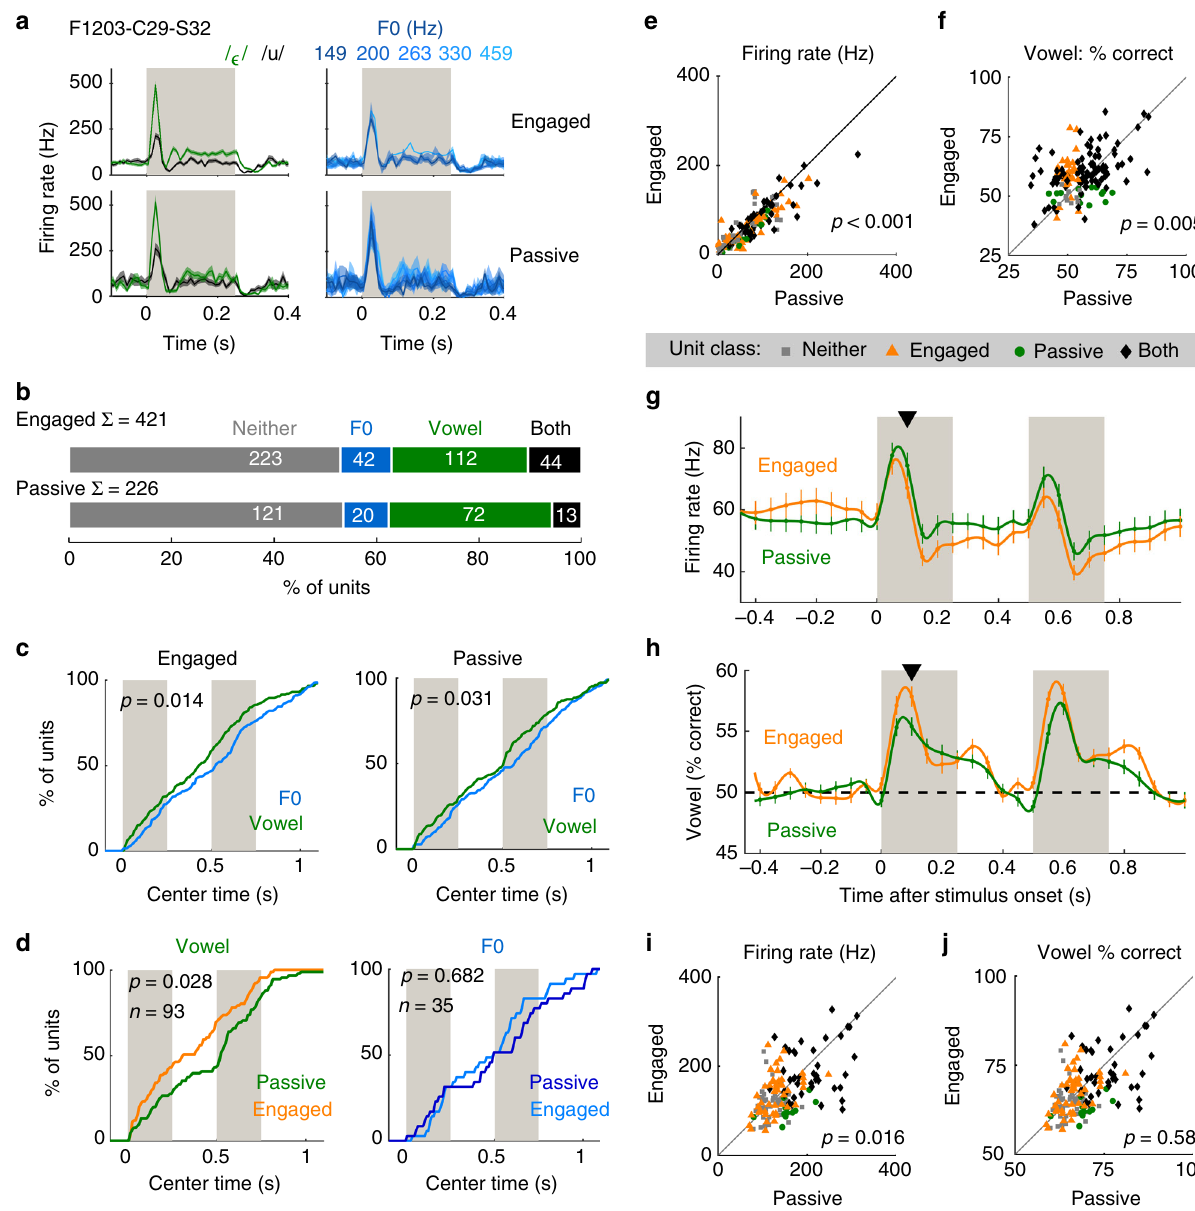
Fig. 3 Modulation of auditory processing by task engagement. a Example unit responses recorded during task engagement and passive listening to vowels (/u/: black; / ε /: green) varying in F0 (blue). Data are shown as mean ± s.e.m. fi ring rates across trials (sample sizes given in Supplementary Table 6). b Proportion of units informative about vowel identity and/or F0. Σ shows sample size; note that not all units recorded during passive listening were recorded during task engagement. c Cumulative density functions (CDF) showing the distribution of decoding time windows giving best performance when decoding vowel (green) and F0 (blue). Data are shown for all units that were informative about vowel and/or F0 in passive or engaged conditions. Values ( p ) indicate comparison of median center time between decoding of vowel and F0 (rank-sum test). d CDFs showing center time of windows giving best decoding performance in engaged and passive conditions. Data are shown for units informative about vowel (left, engaged: orange; passive: green) or F0 (right, engaged: light blue; passive: dark blue) during task engagement. Values ( p ) indicate comparison of median center time between engaged and passive conditions (sign-rank test). e – f Paired comparison of mean fi ring rate ( e ) and decoding performance ( f ) in the 100 ms after stimulus presentation for units recorded during engaged and passive conditions ( n = 154). Markers show individual units, labeled by classi fi cation as informative about vowel identity in engaged and passive (black diamonds), engaged only (orange triangles), passive only (green circles) or neither condition (gray squares) when decoded using optimized time windows. Values ( p ) indicate comparisons between engaged and passive conditions (sign-rank test). g , h Paired comparison of fi ring rate and decoding performance in roving 100 ms windows. Data is shown as mean ± s.e.m. across units ( n = 154) at 50 ms intervals (spline interpolated across means). Black triangles indicate comparison shown in e and f . i , j Firing rate ( i ) and decoding performance ( j ) using optimized time windows (optimized independently in passive and engaged conditions). Values ( p ) indicate comparisons between engaged and passive conditions for all units (sign-rank test). Markers shown as in